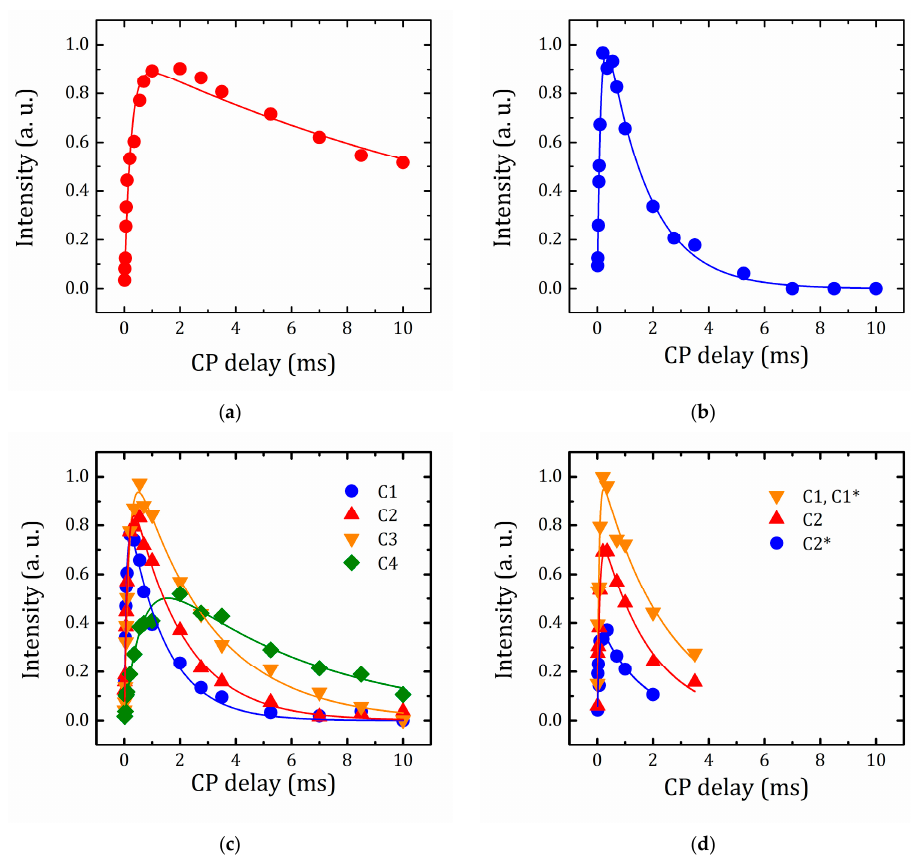
Figure 10. Integral peak intensity for carbon atoms in HLT 3 × MeOH ( a ), HLT 3 × MeNH 2 ( b ), HLT 3 × BuNH 2 ( c ), and HLT 3 × MEA ( d ). Table 3. Values of T CH and T 1 ρ (H) for the specific 13 C nuclei with an isotropic chemical shift δ iso in the studied hybrids, as derived from 1 H- 13 C cross-polarization/magic angle spinning (CP/MAS) NMR measurements.